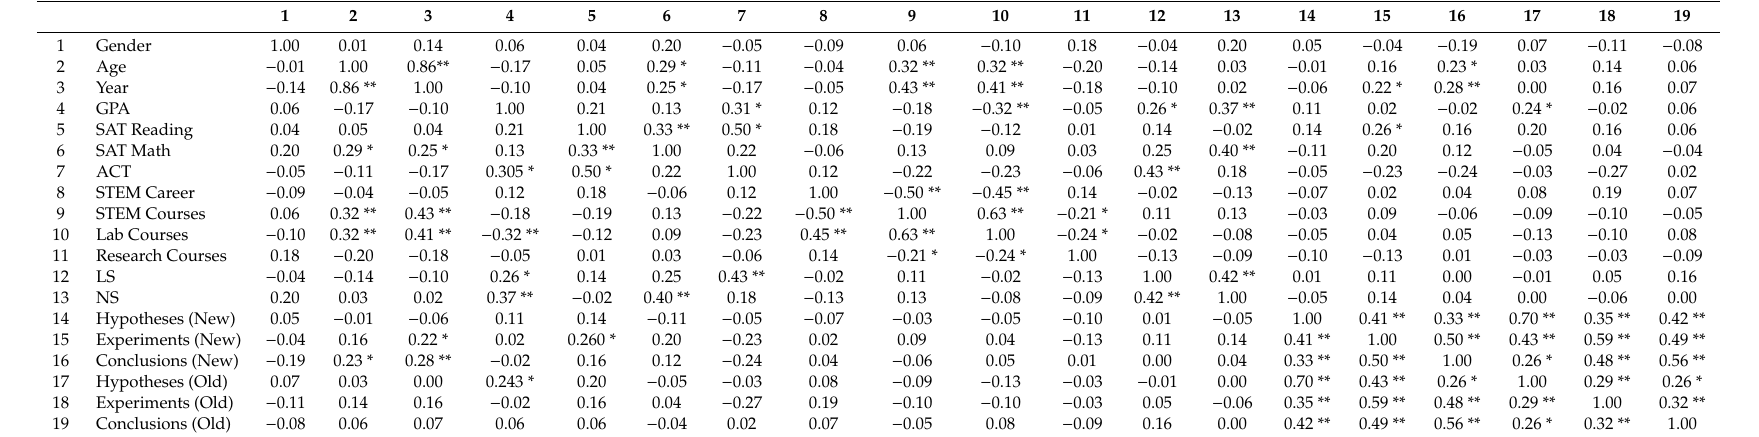
Table 2. Study 1